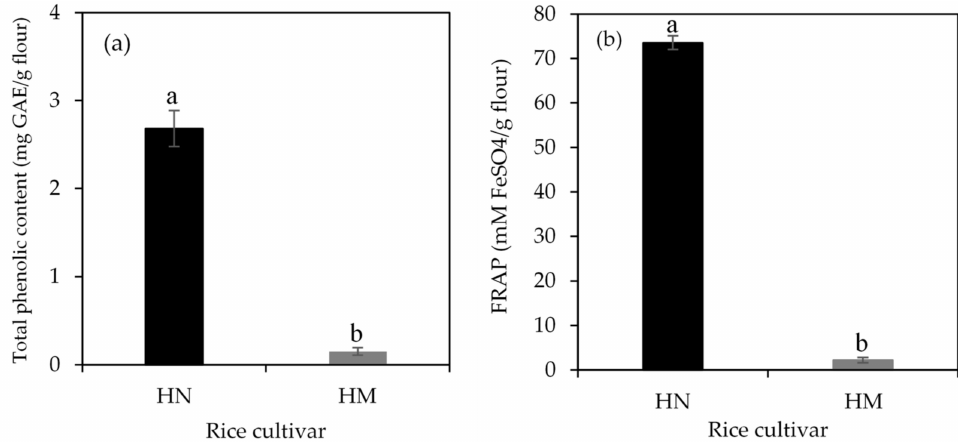
Figure 3. Total phenolic content ( a ) and ferric reducing antioxidant power (FRAP) ( b ) of Hom Nil rice flour (HN) and Hom Mali 105 rice flour (HM). The results are expressed as mean ± standard error of the mean (SEM), n = 3. The different letters denote statistically significant differences in mean values ( p <